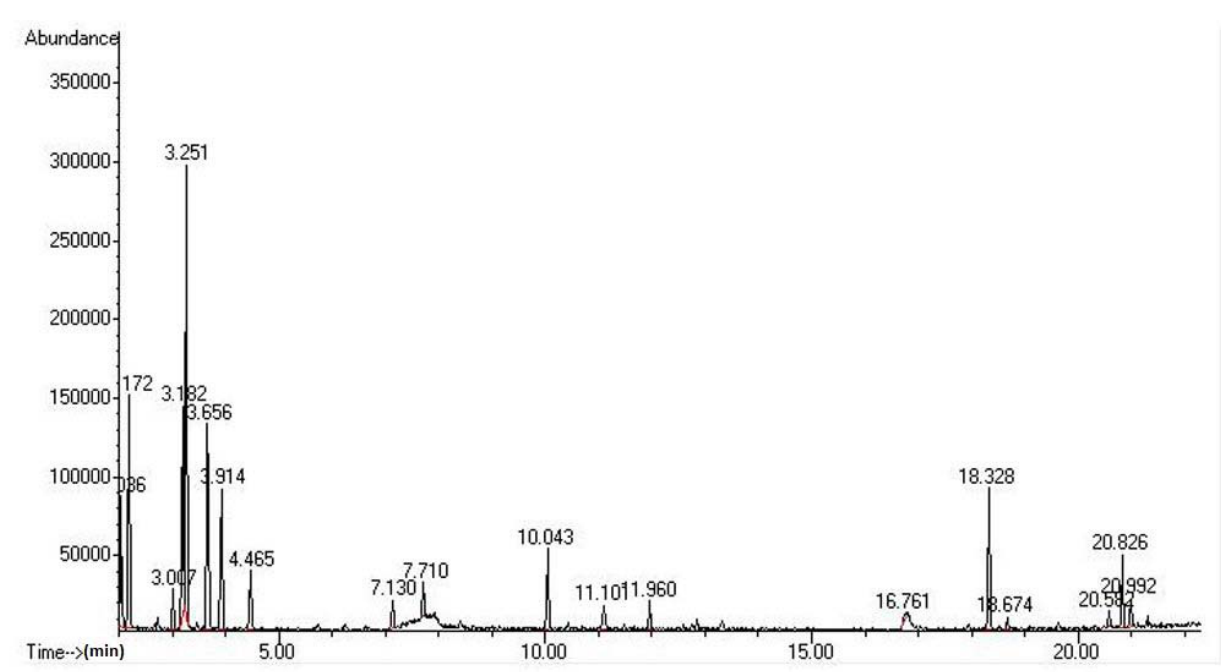
Figure 1. GC profile of volatile compounds extracted from Budu 1 using a DB-WAX